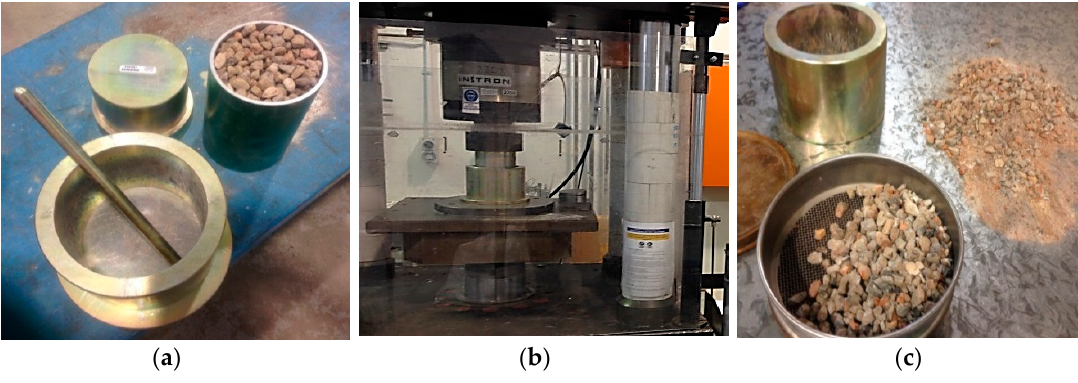
Figure 7. Crushing Value Test for Coarse Aggregates. ( a ) apparatus to crush aggregate; ( b ) compression machine ; ( c ) aggregates after crushing and sieving. Table 6. The Results of Aggregate Crushing Value Test for Coarse Aggregates and Crushing Value Limits for Dense Graded Asphalt Based on Australian Standards.